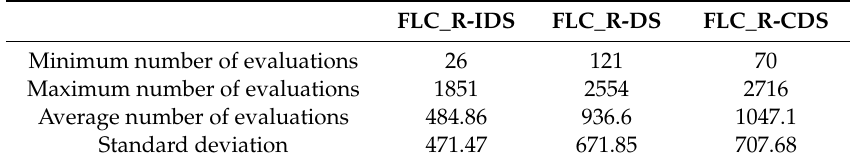
Table 2. Comparison of the evaluation numbers of various existing models in the learning